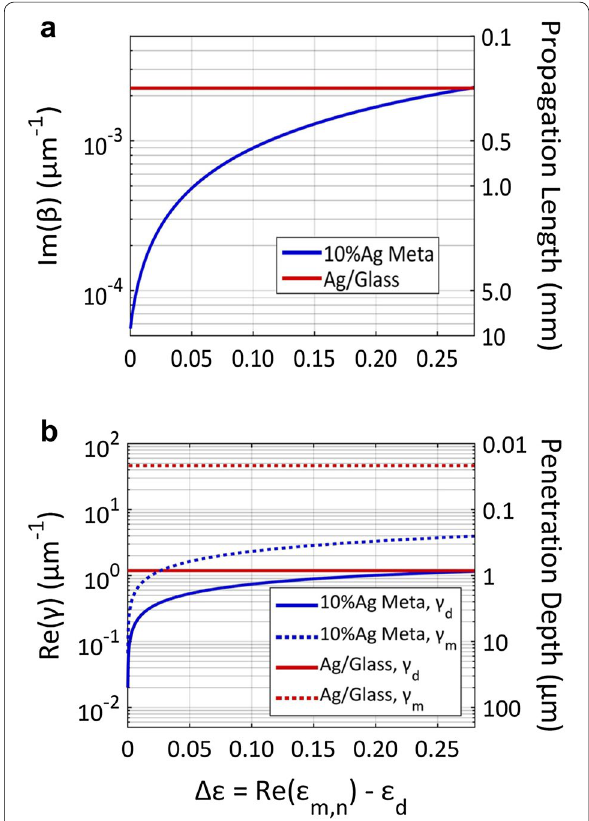
Fig. 3 Surface-bound wave at an interface of hyperbolic metamaterial ( ε m with f Ag 0.1) and dielectric ( ε d ) calculated at 1.3 µm = wavelength. a Propagation constant ( β , left) and propagation length (1/2Im( β ), right). b Lateral decay constant ( γ , left) and penetration depth (1/Re( γ )), right) in dielectric side (solid) and metamaterial side (dotted). The case of bulk Ag on soda-lime glass (solid, red) is also shown for